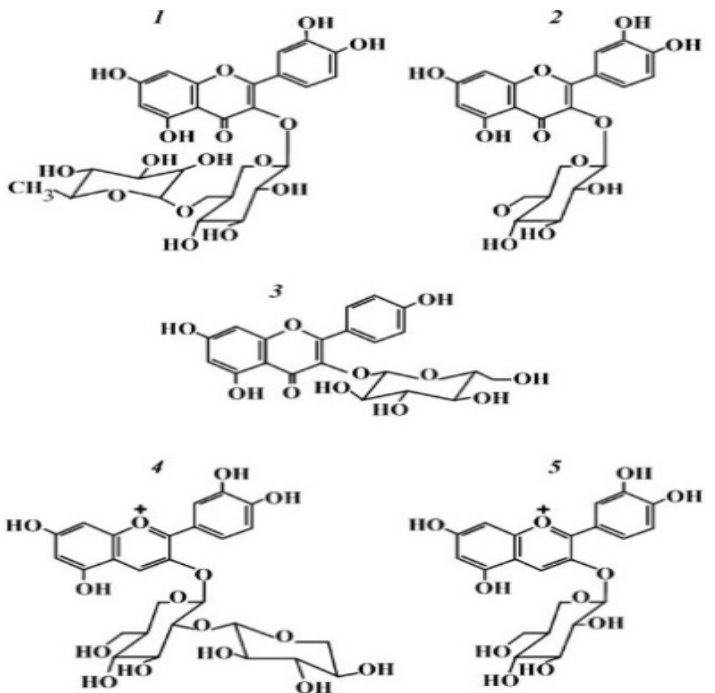
Figure 1. Chemical structures of the main flavonols from Sambucus nigra: rutin ( 1 ); isoquercitrin ( 2 ); astragaline ( 3 ) and antocyanins: cyanidin-3-sambubioside ( 4 ); cyanidin-3-glucoside ( 5 ) (Created with BioRender.com) [16].